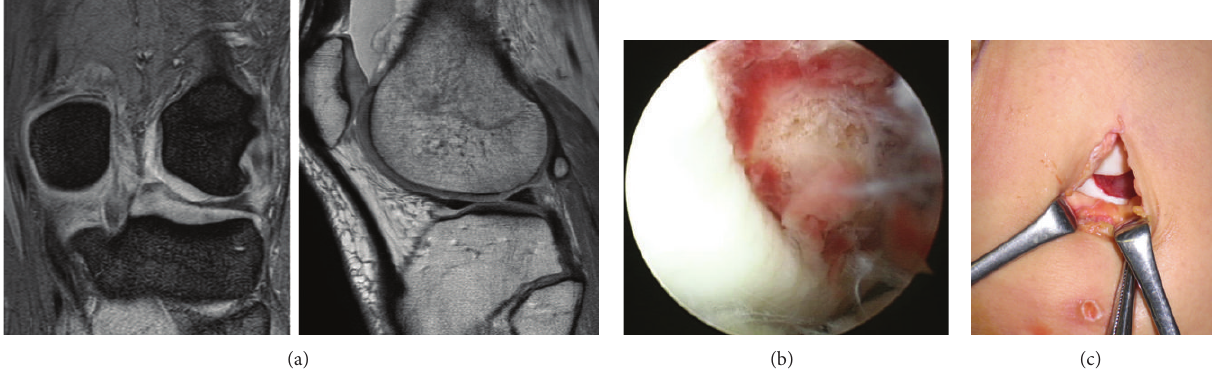
Figure 1: Findings in Patient 1. (a) MRI, showing an osteochondral defect in the lateral femoral condyle. (b) Arthroscopy, showing a 2 × 1.5-cm osteochondral defect in the lateral femoral condyle. (c) Arthrotomy was applied, fixing the osteochondral